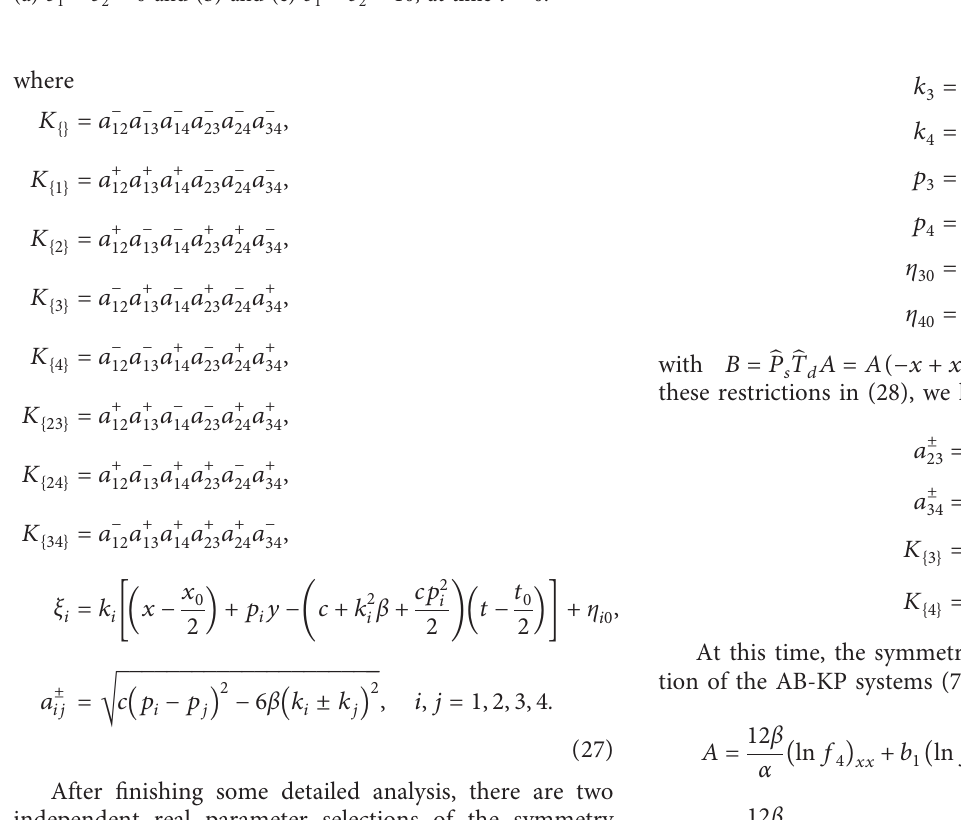
� b � 10, at time t � 1 2